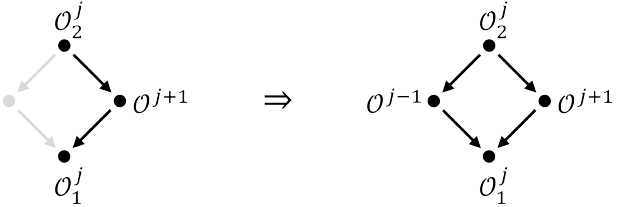
Figure 19: The commutation relation [ B + , B − ] = 0 completes the folded-line struc- ture to a diamond